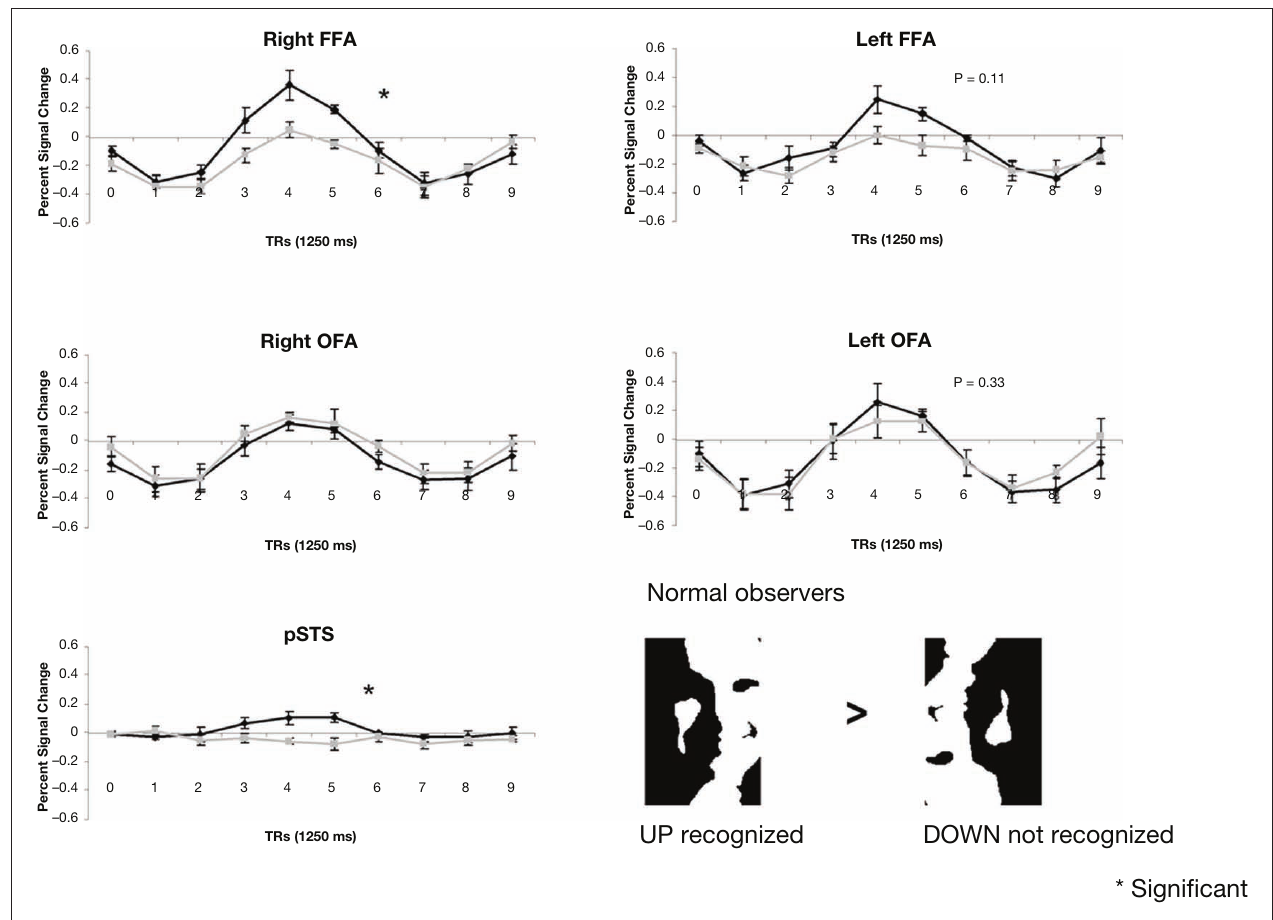
Figure A5 | Time-course of activation in face-sensitive regions for the group of normal participants in the Mooney face detection task, for correct trials only. Only the right FFA and the right STS to a lesser extent showed a larger response to stimuli correctly detected as